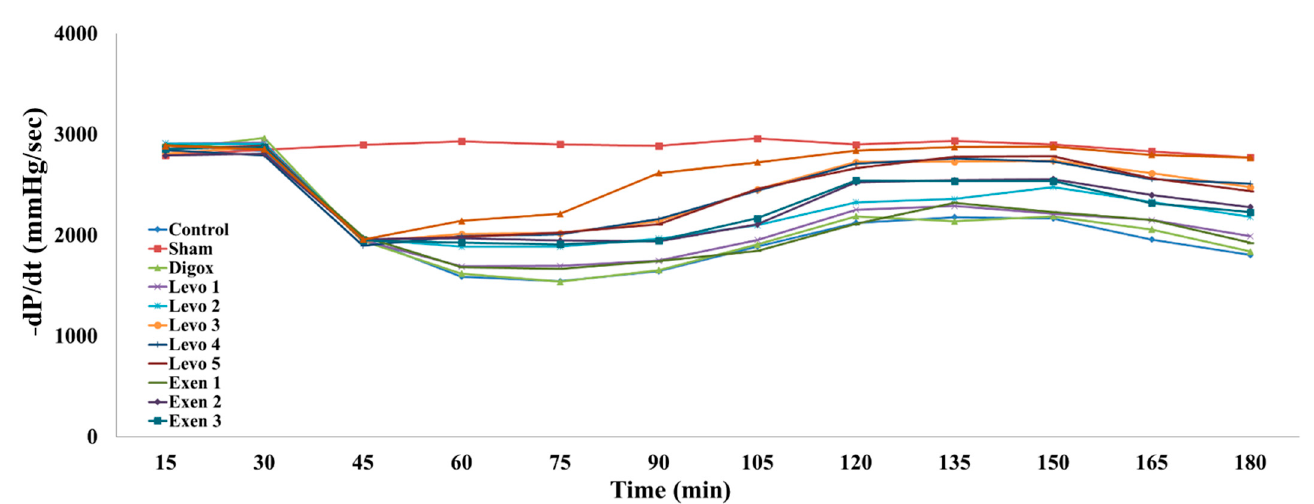
Figure 9. Changes in − dP/dt across groups over time.